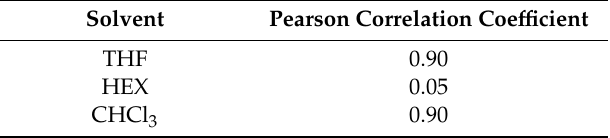
Table 4. Pearson correlation coe ffi cient of the resistance variation in function of the solvent.